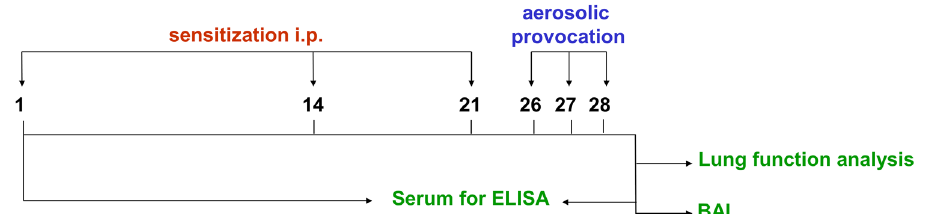
Figure 5. Test protocol. Mice were sensitized to ovalbumin (OVA) by intraperitoneal injections on days 1, 14, and 21. To induce an allergic airway inflammation, mice received allergen challenges via the airways delivered by nebulization with OVA on days 26, 27 and 28. The control group received PBS instead of OVA. To quantify the immunoglobulin classes in serum using ELISA, blood samples were taken on the day before the first sensitization and on day 30. Head-out body plethysmography including methacholine provocation was used to assess the lung function on day 29. Bronchoalveolar lavage was performed on day 30. BAL fluids were evaluated for cytokine levels as well as eosinophil